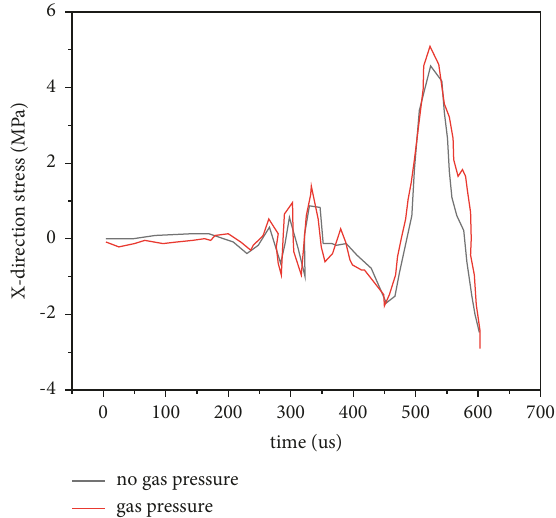
Figure 3: Stress time history curve in the X direction at measuring point B.